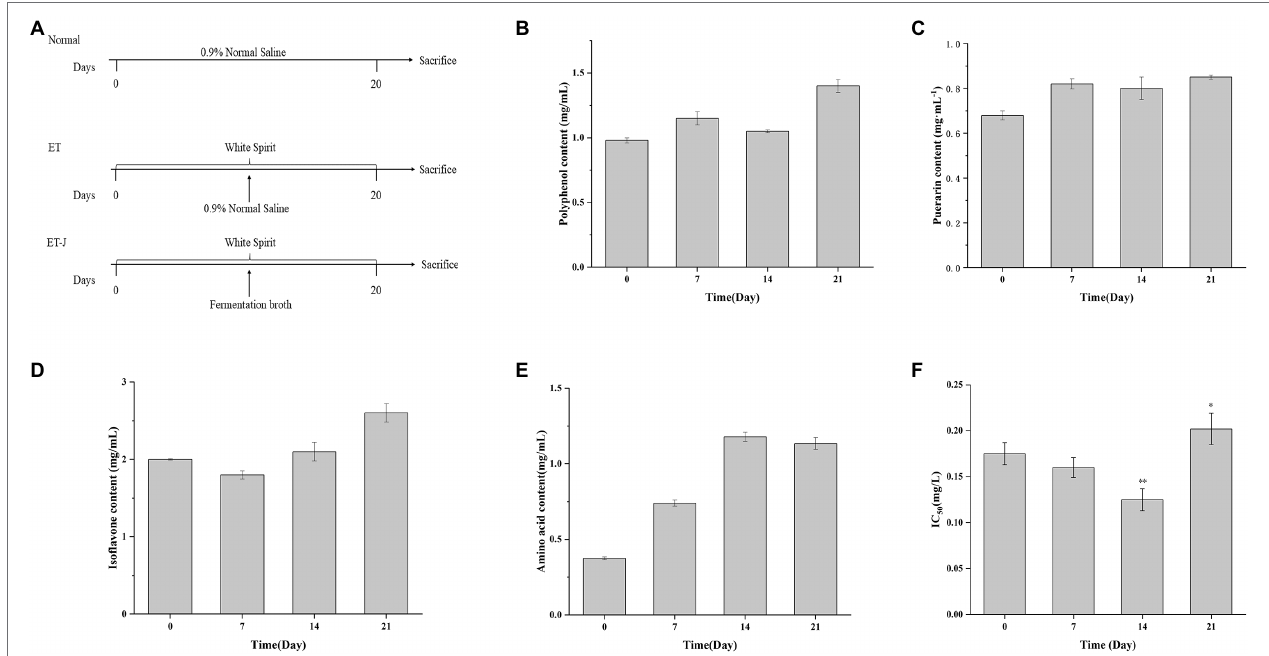
FIGURE 1 | (A) Schematic diagrams showing the three treatment strategies, (B) total polyphenol concentration, (C) total puerarin concentration, (D) total isoflavone concentration, (E) total amino acid concentration, and (F) IC 50 of fermentation broth during Lactobacillus rhamnosus 217-1 fermentation. Results are expressed as the mean ± SD ( n = 3). * p < 0.05 vs. 0 day; ** p < 0.01 vs. 0 day.